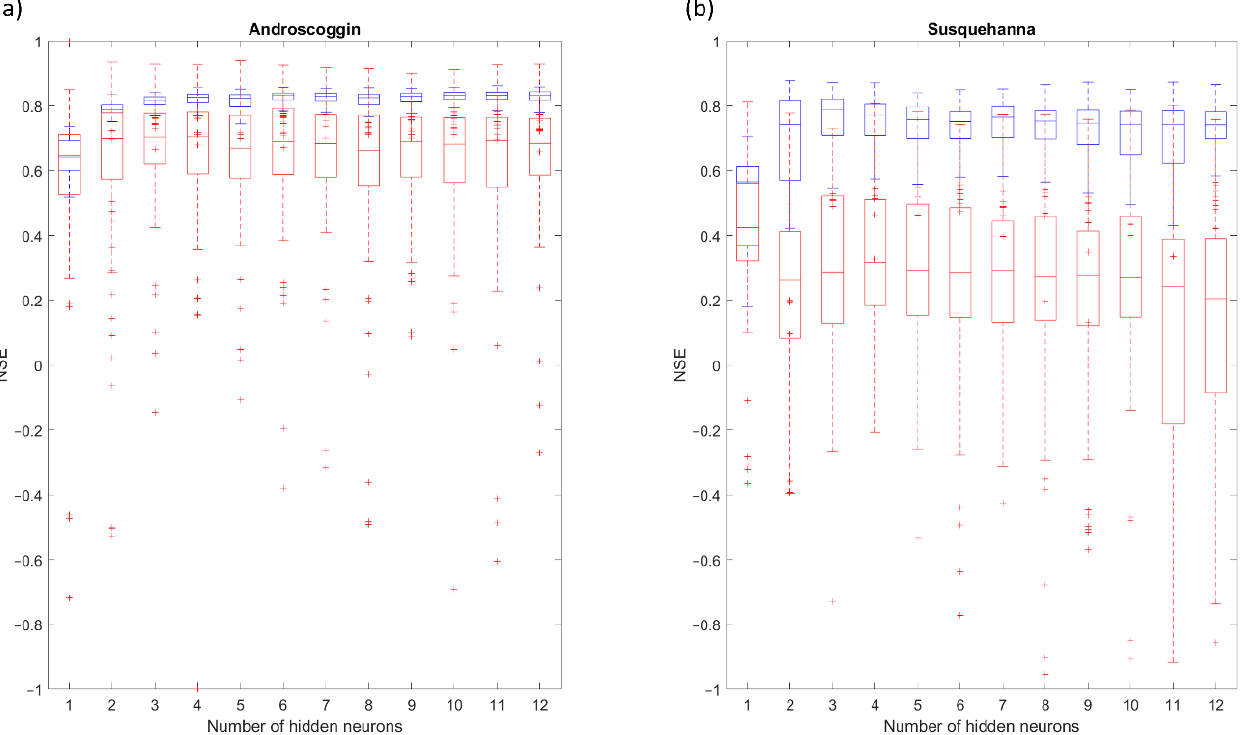
Figure 6. Evaluation of the number of neurons in the hidden layer for ( a ) the Androscoggin and ( b ) the Susquehanna watersheds. Blue boxplots are relative to the training step, while red are for the validation step. Each boxplot is plotted with the 16 summers used in the cross-validation process.